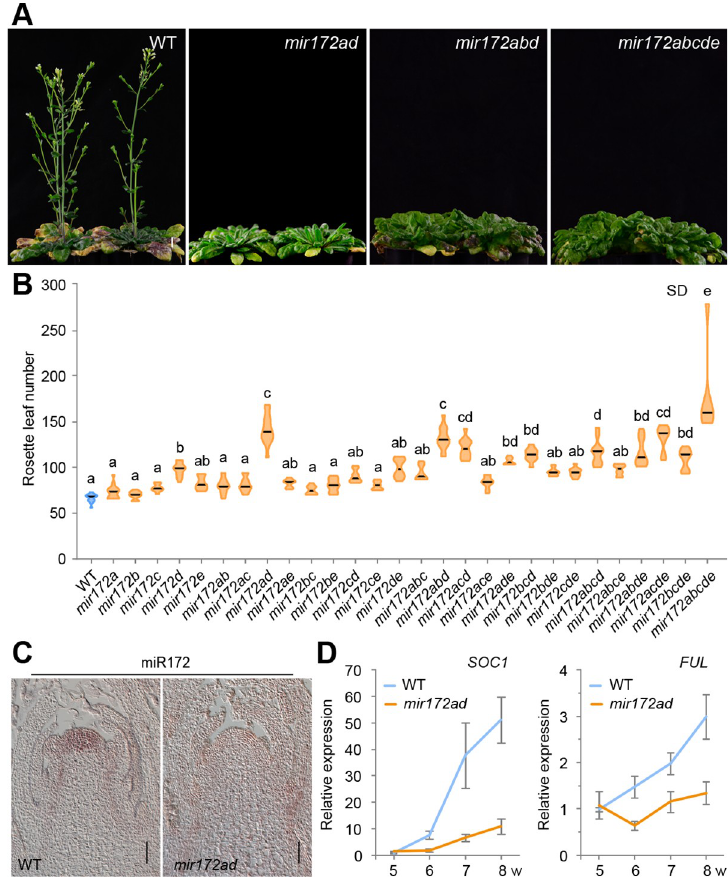
Fig 5. Flowering time of WT and the mir172 mutants in short days. (A) Flowering time phenotype of the mir172 mutants. Plants were grown at 22˚C in short days (SD). Four representative plants are shown. (B) Quantification of flowering times of the mir172 mutants. Lines show mean ( n = 6–16). The statistically significant differences are determined by ordinary one-way ANOVA ( p < 0.05). See also S1 and S4 Tables. (C) Expression of miR172 in the shoot apices of WT and the mir172ad mutant. Plants were grown at 22˚C in short days. Scale bars represent 50 μ m. (D) Expression of SOC1 and FUL in WT and the mir172ad mutants. Plants were grown at 22˚C in short days, and the shoot apices were harvested at different time points as indicated. Expression was normalized to TUB . Two technical replicates for each biological replicate ( n = 2) were performed. Error bars represent SD. The data underlying this figure are included in S1 Data. FUL , FRUITFULL ; SOC1 , SUPPRESSOR OF OVEREXPRESSION OF CO 1 ; TUB, β - TUBULIN-2 ; WT, wild